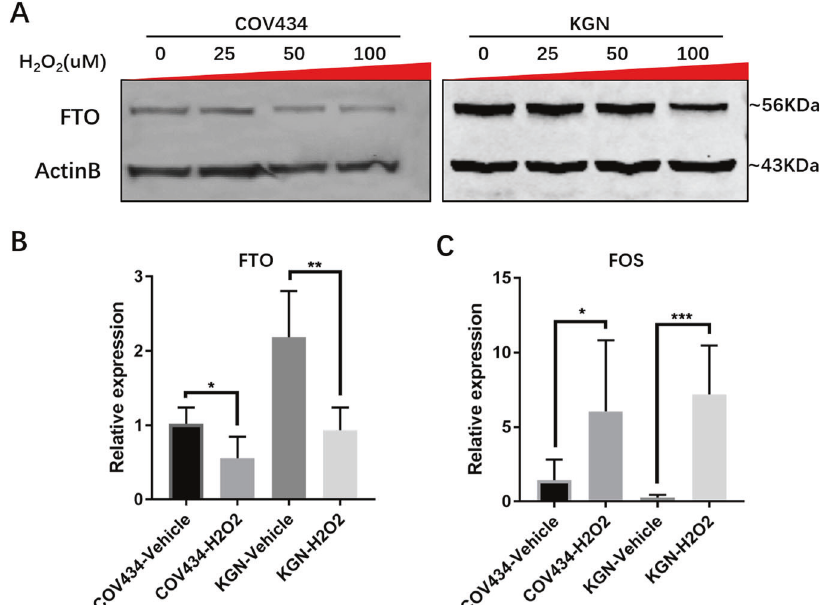
Fig. 6 ROS may be the cause of abnormal FTO levels and m6A disorder in aged ovarian granulosa cells. A Western blot analysis showed that FTO was downregulated with increasing levels of hydrogen peroxide. B RT-PCR showed the downregulation of FTO by hydrogen peroxide. C The effect of hydrogen peroxide on the expression of FOS in GCs was shown by RT-PCR. Performed three times. The error bars indicate SD; * p < 0.05, *** p <